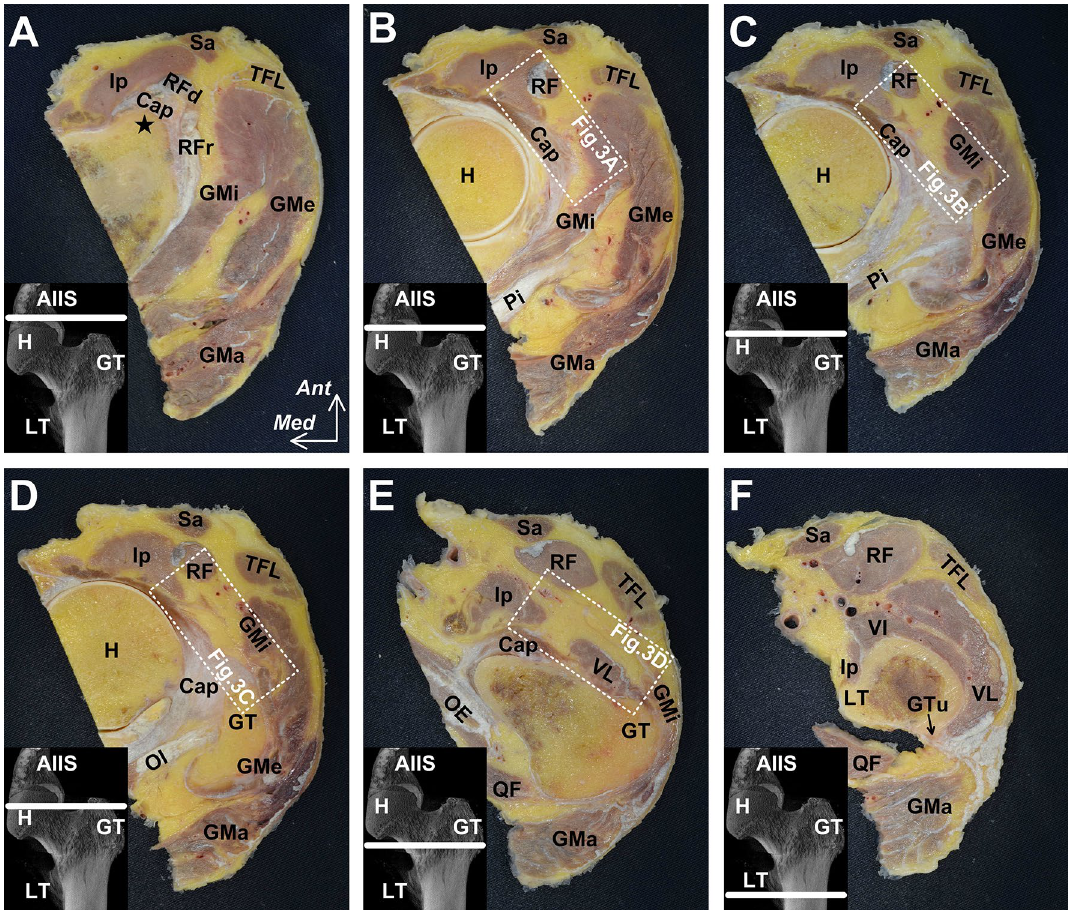
Figure 1. Serial axial sections of the anterior region of the joint capsule. The locations of each axial section are indicated using white lines, in each lower left panel, on the micro-CT images of the anterior aspect of the left hip ( A – F ). The most proximal level ( A ) is the inferior area of the anterior inferior iliac spine (indicated by the star), and the most distal level ( F ) is the superior end of the gluteal tuberosity (GTu). The boxed regions indicate the selected parts for histological analysis, as shown in Fig. 3. The fat pad superficial to the joint capsule (Cap) spreads distally to the superficial portion of the vastus lateralis (VL). AIIS anterior inferior iliac spine, GMa gluteus maximus, GMe gluteus medius, GMi gluteus minimus, GT greater trochanter, H head of femur, Ip iliopsoas, LT lesser trochanter, OE obturator externus, OI obturator internus, Pi piriformis, QF quadratus femoris, RF rectus femoris, RFd direct head of the RF, RFr reflected head of the RF, Sa sartorius, TFL tensor fasciae latae, VI vastus intermedius, VL vastus lateralis; Ant anterior, Med